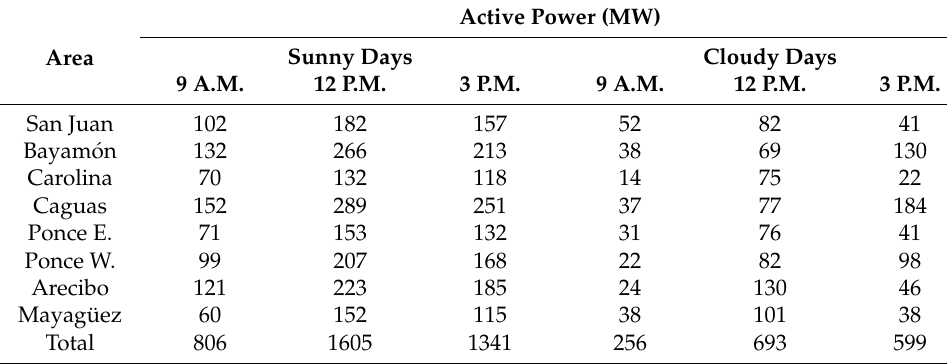
Table 15. Potential PV production by area (20% of PV penetration).